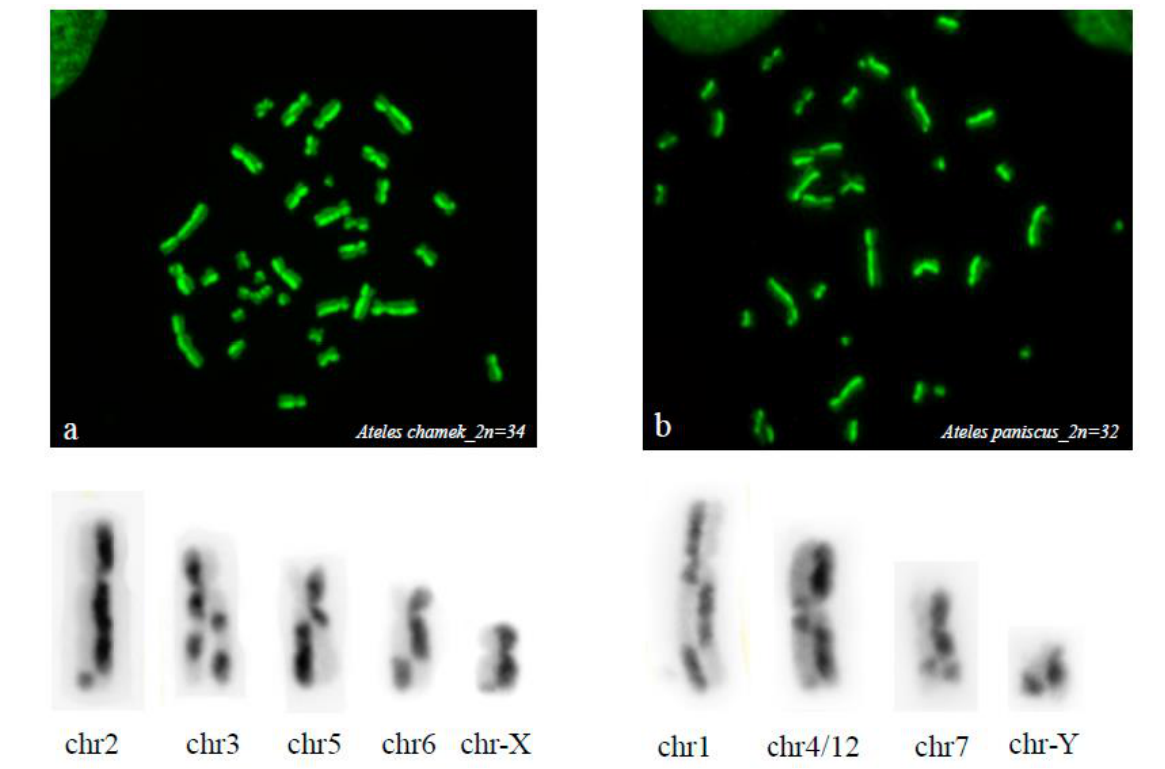
Figure 3. G-SCEs A. chamek and A. paniscus . Examples of chromosome pairs involved in evolution- ary rearrangements for the genus. ( a ) chromosome pairs 1, 2, 3, 4, 5, 6, and 7 in A. chamek ; and ( b ) chromosome pairs 1, 2, 3, 4/12, 7, and 10 in A. paniscus .